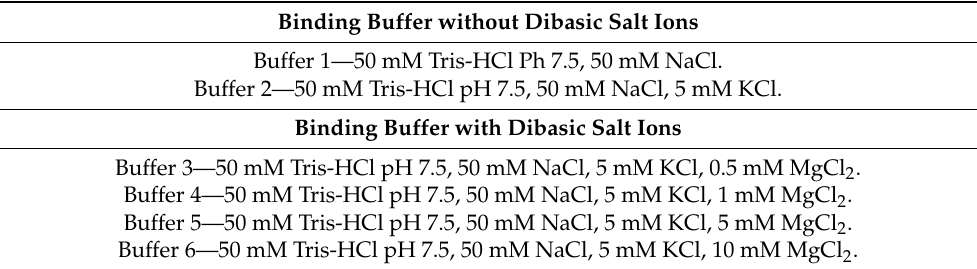
Table 5. Binding buffers with different ionic strengths.